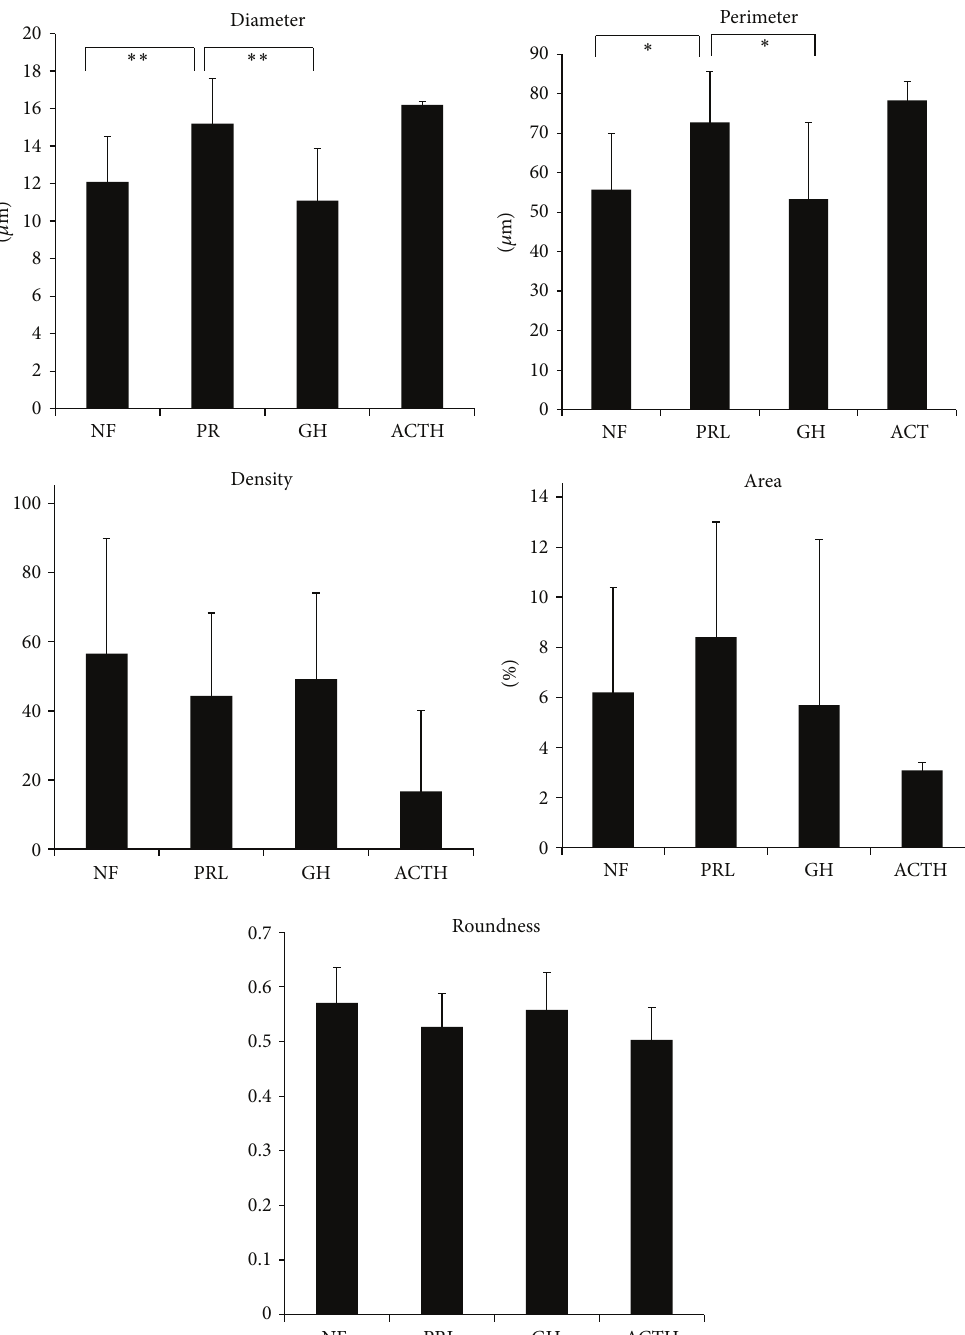
Figure 5: Differences of vascular architecture in macroadenoma. Vessel diameter and perimeter are significantly larger in prolactin-secreting adenomas than nonfunctioning and GH-secreting adenomas. ∗ 𝑃 < 0.05 ; ∗∗ 𝑃 < 0.01 .